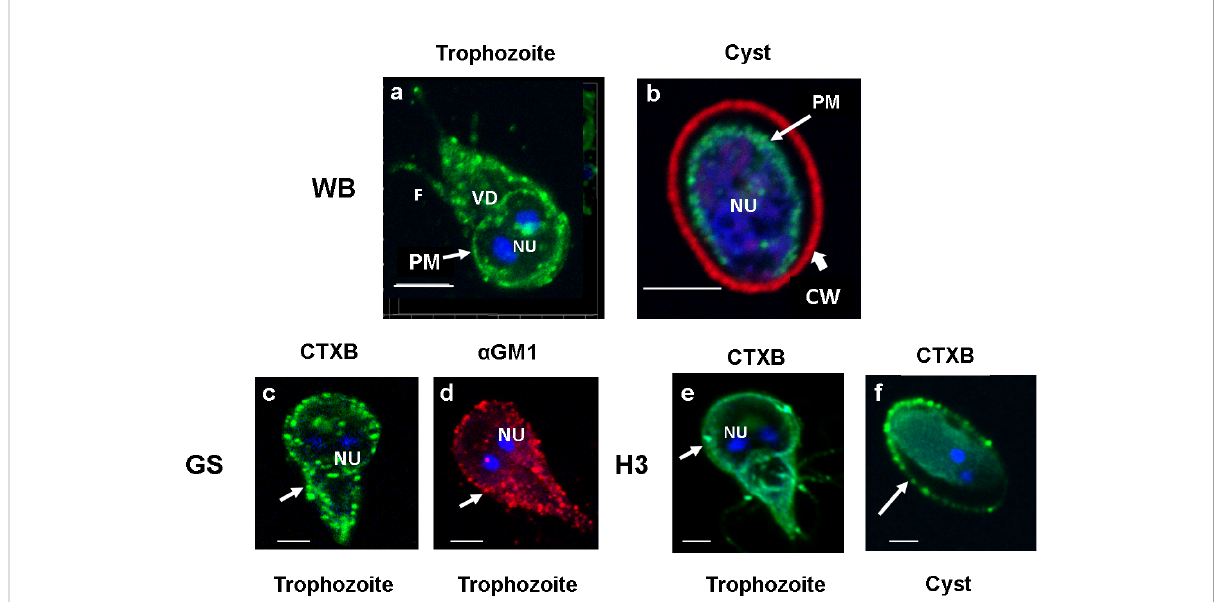
FIGURE 1 Panel (A) . Staining of lipid rafts in WB, GS and H3 isolates of Giardia . Trophozoites were labeled with Alexa Fluor (488)-conjugated CTXB (images A , C and E ) and GM1 antibody (image D) Immunostaining of raft domains in plasma membranes is visible. DAPI-stained nuclei (NU) are also visible. The image of CTXB-labeled Giardia trophozoites and cysts (images B , F ) were captured with the help of a confocal microscope (Carl Zeiss LSM 700) and analyzed by Zen 2009 software. Z-stacks were acquired, and a 3D model was reconstructed from the 12 optical sections of the z-stacks with a slice thickness of 0.37 m m each. Bars, 5 m